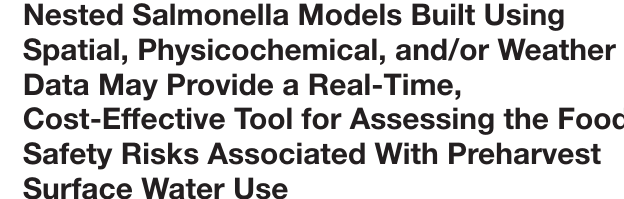
( Supplementary Table 2 ). The top-performing Salmonella nested models were the partial decision tree (PART) built using weather features, and the ridge regression built using microbial and physicochemical water quality features ( Figure 7